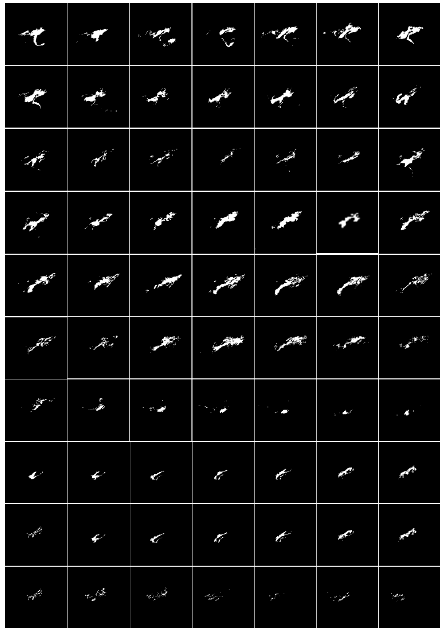
Figure 3. Binary time-series validation data after pre-processing.